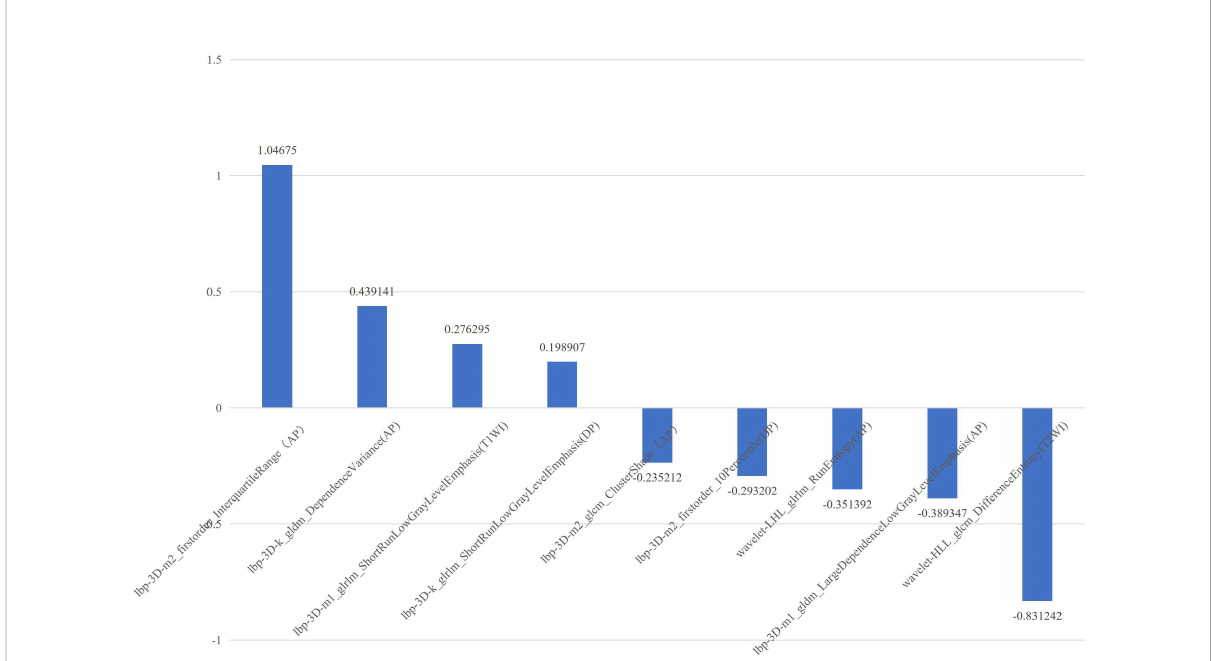
FIGURE 2 The selected features with correlation coef fi cients of mpMRI radiomics model. The x-axis represents radiomics features, with their coef fi cients in the multivariate logistic regression analysis plotted on the